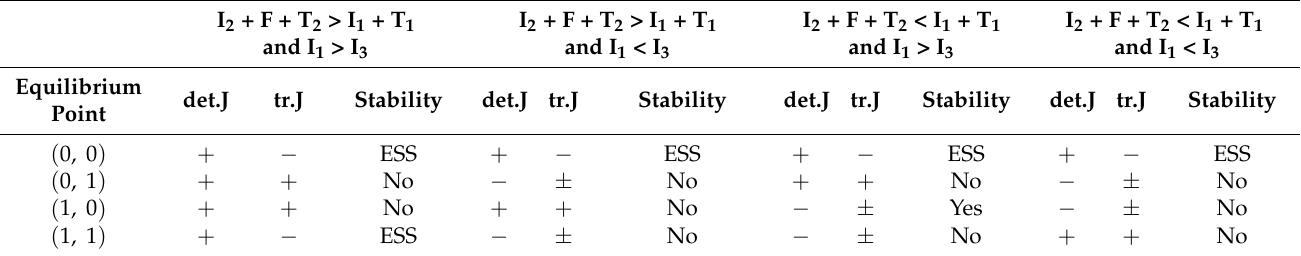
Table 3. Results of local equilibrium stability of the game system between farmers and agricultural